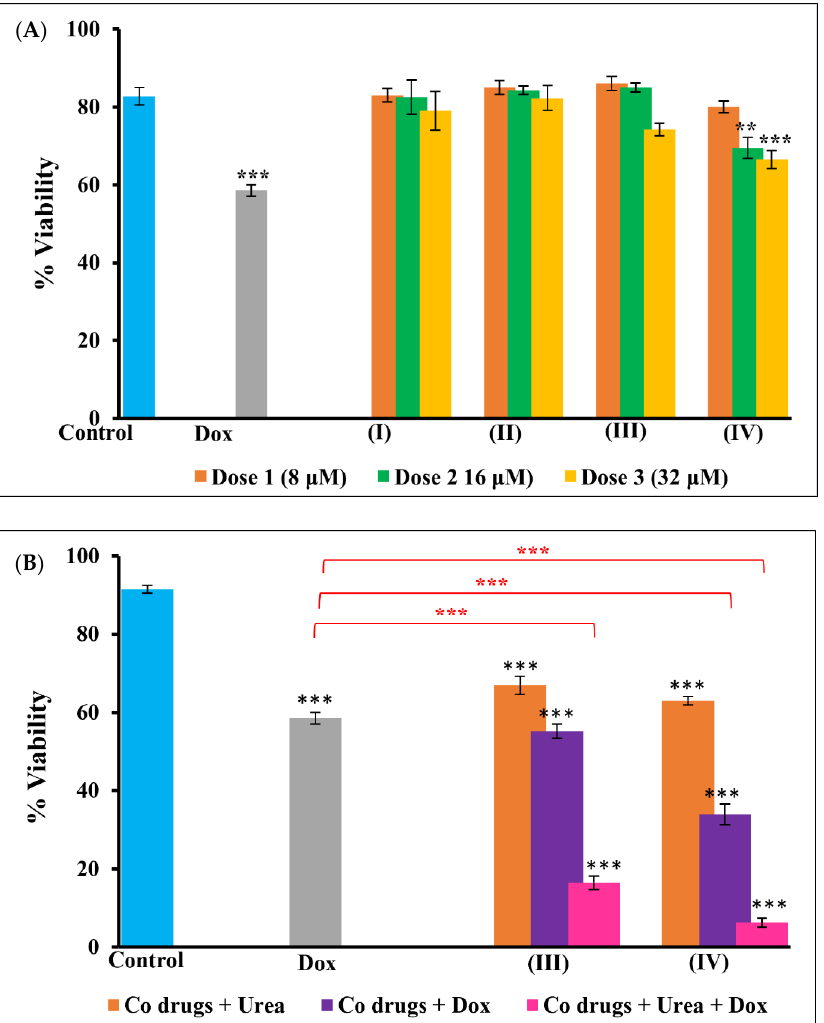
Figure 6. Trypan blue viability test in A549 cells. Graph ( A ) shows the viability of A549 cells treated with complex alone and in combination with doxorubicin. Graph ( B ) shows the commendable increase in the ability of doxorubicin in inducing cell death when combined with urea. As seen in other assays, cobalt III and IV complexes induced better toxicity in A549 cells compared to other complexes as seen in ( A ). Moreover, urea and doxorubicin induced more cell death whereby these cells stained well with trypan blue. Significance in these groups can be seen increased by several folds. Results are significantly different at ** p < 0.01 and *** p < 0.001 when compared to control and